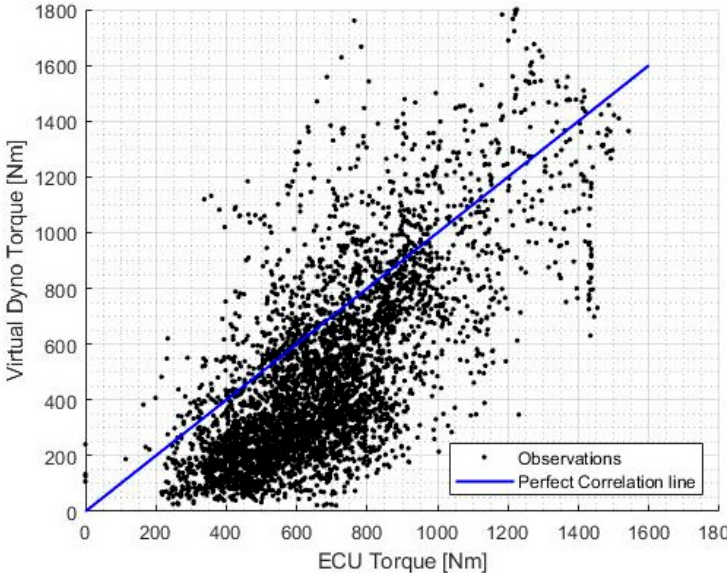
Figure 12. Plot of correlation between torque values.